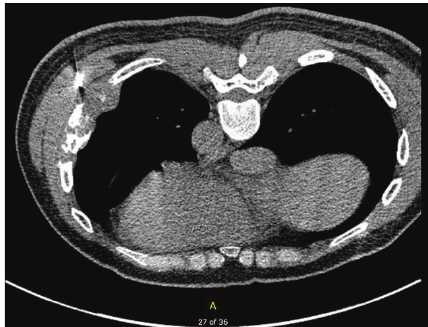
Figure 2: Axial CT chest without contrast, soft tissue views demonstrating the patient in prone position with CT-guided biopsy needle on satisfactory trajectory to the bony and soft tissues lesion.